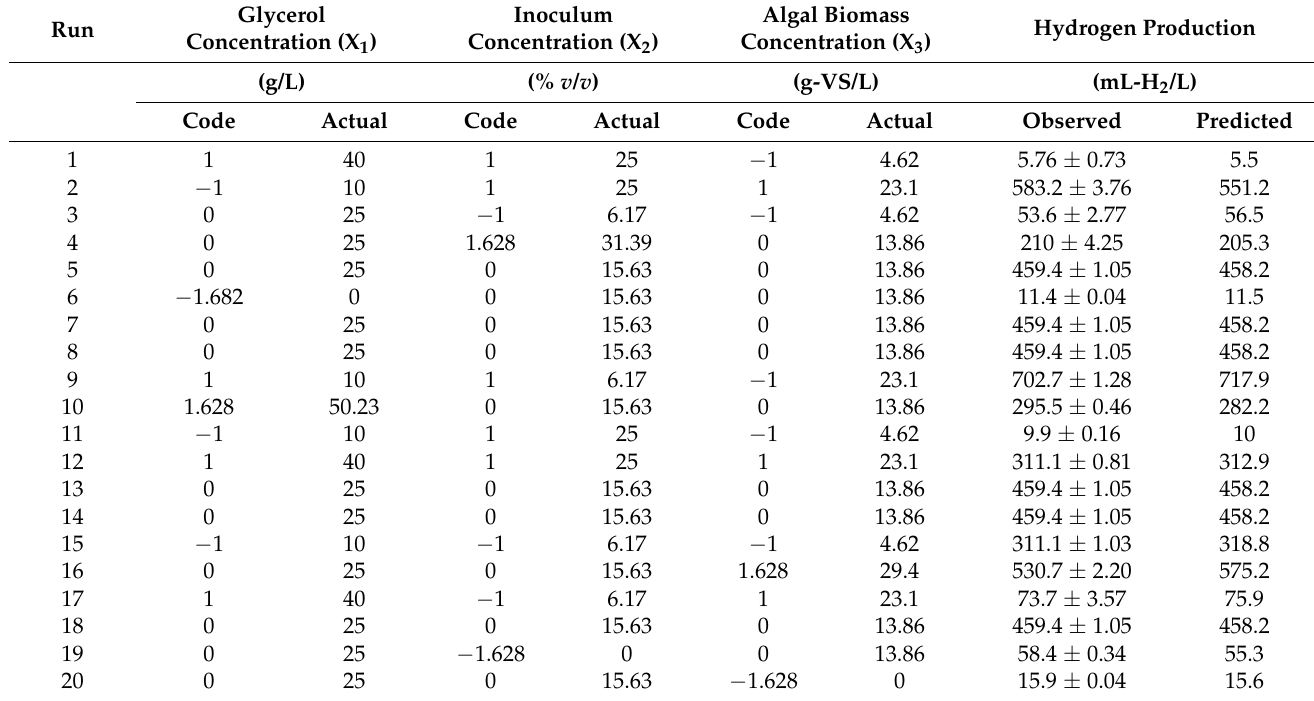
correlate the response to the independent variables [25]. The statistical software Design- Expert (Demo version 7.0, Stat-Ease, Inc., Minneapolis, MN, USA) is used for regression and graphical analysis of the experimental data. The right consistency of the quadratic model is represented by the determination coefficient, R 2 , and the F-test was used to verify its significance. The conditions of each trial are shown in Table 1. Table 1. Central composite design matrix defining the concentration of crude glycerol (X 1 ), the concentration of inoculum (X 2 ), and the concentration of algal biomass (X 3 ) and their effect on the production of hydrogen. Glycerol Inoculum Algal Run